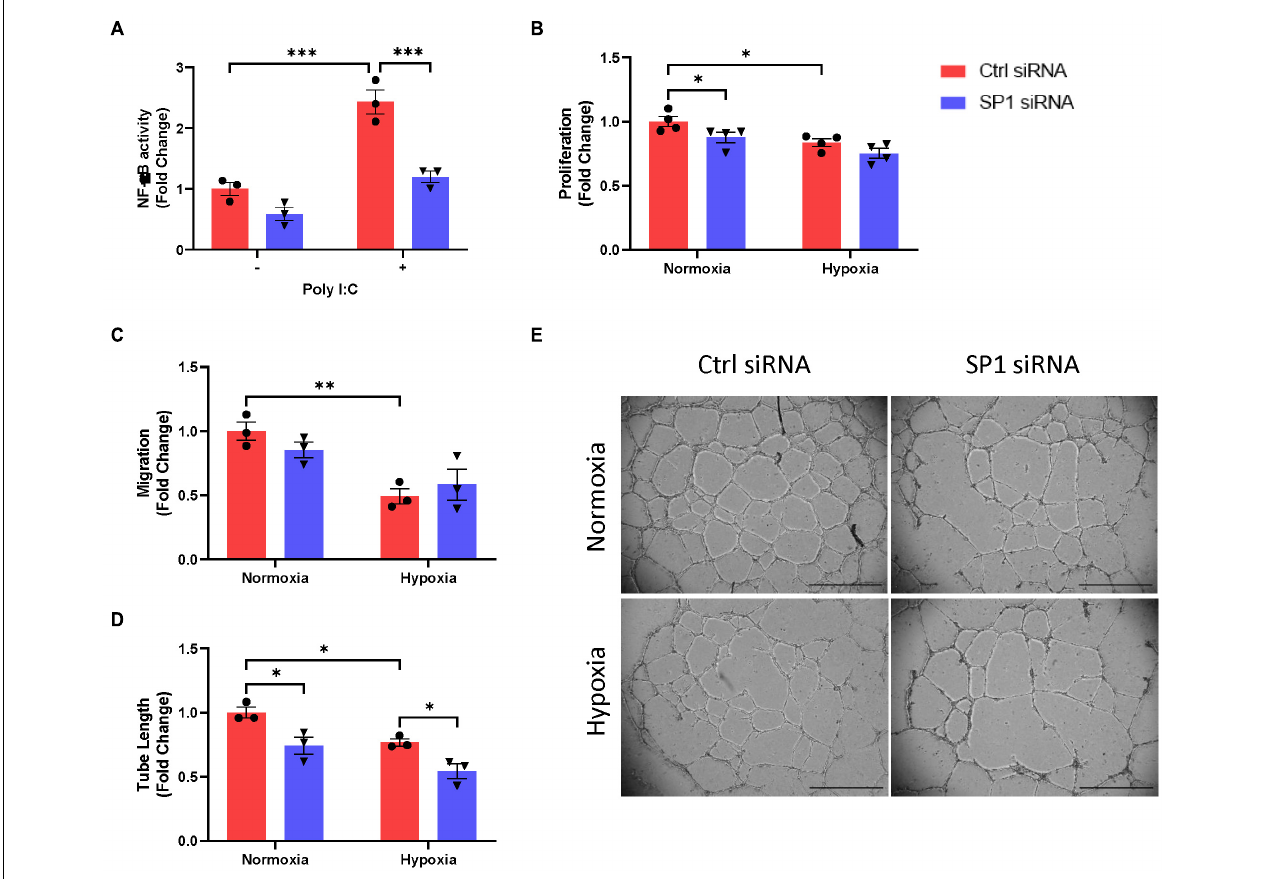
FIGURE 4 | SP1 inhibits endothelial function. (A) Luciferase reporter assay was used to determine NF- κ B signaling in HEK293FT cells after siRNA-mediated knockdown of SP1 ( n = 3). (B) Proliferation of HUVECs after SP1 -knockdown and hypoxia was determined by BrdU-incorporation ( n = 4). (C) Migration of HUVECs after SP1 -knockdown and hypoxia was determined by scratch wound healing assay ( n = 3). (D) Tube formation of HUVECs after SP1 -knockdown and hypoxia was determined by tube formation assay ( n = 3). (E) Representative images of tube formation assay in HUVECs after SP1 -knockdown and hypoxia. Scale bar, 1,000 µ m. Each dot resembles the mean value of all technical replicates from an independent experiment. ∗ p ≤ 0.05, ∗∗ p ≤ 0.01, ∗∗∗ p ≤